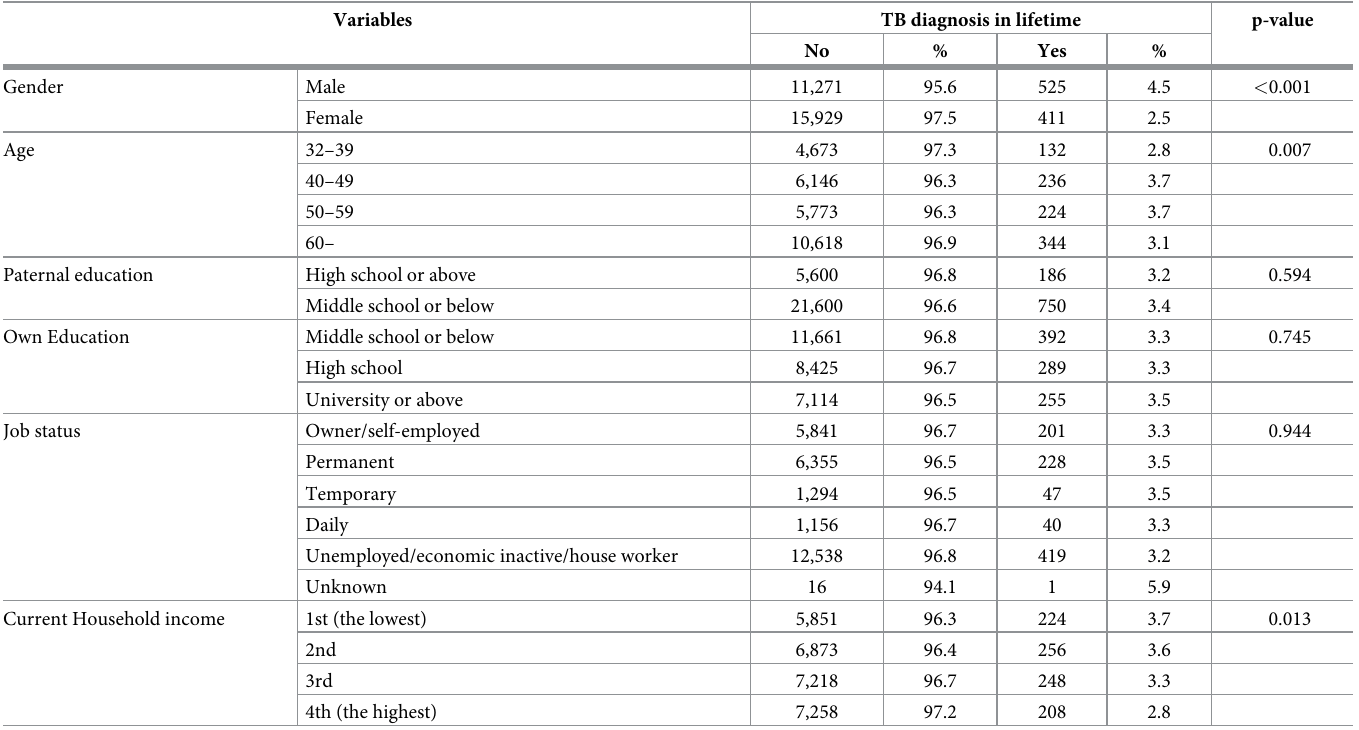
Table 1. Baseline characteristics of all variables by lifetime tuberculosis histories (n =